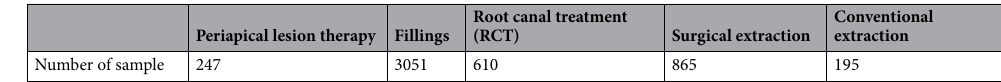
Table 1. Number of each dental therapy in our